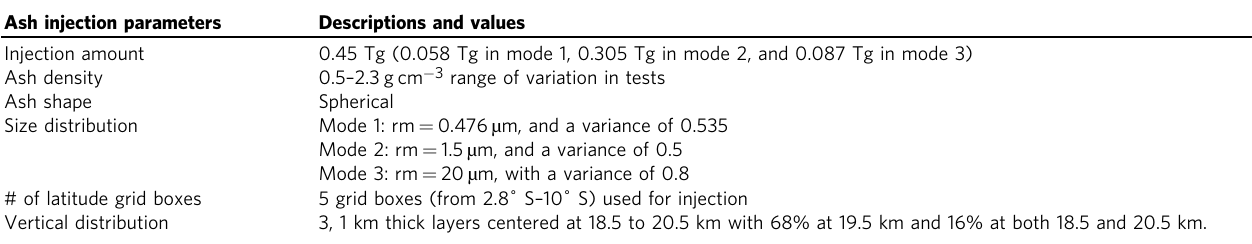
Table 2 The Ash parameters in the Base case and the SO2onAsh